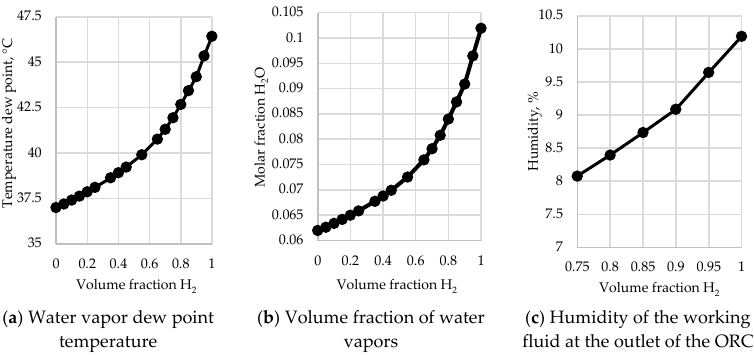
Figure 14. Thermodynamic characteristics of the working fluid at the outlet from the OCR. With a further increase in the hydrogen concentration in the fuel, the partial pressure of water vapor increased. Due to this, after the hydrogen volume fraction in the fuel exceeded 75%, the dew point temperature reached 42 ◦ C. The specific humidity of the exhaust gases depending on the hydrogen volume fraction in the fuel is shown in Figure 14c.